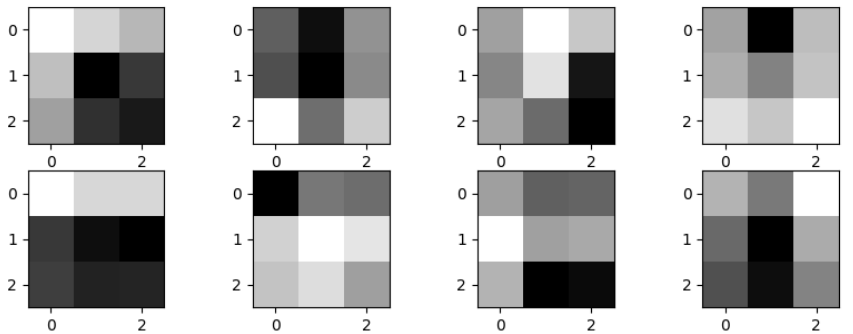
Figure 10. Weights learned by the first convolutional layer.